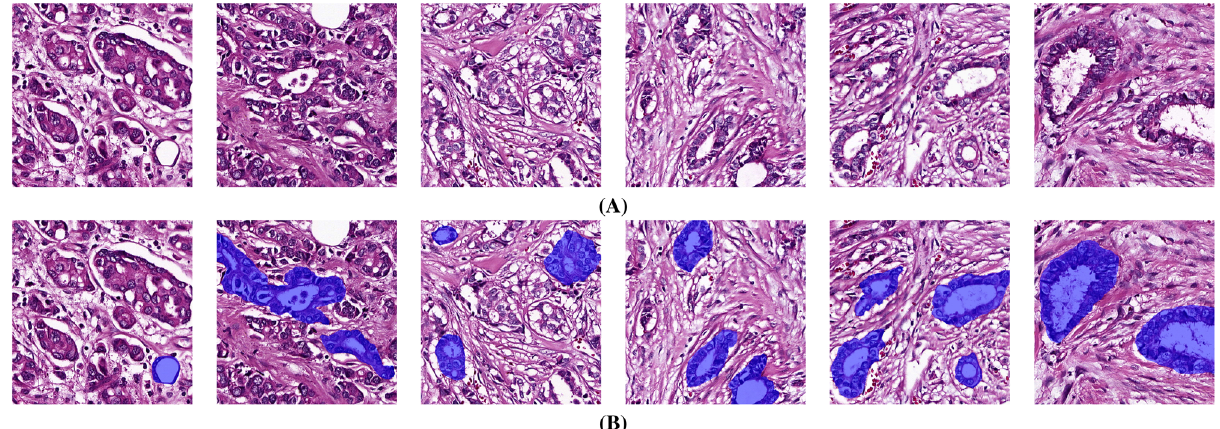
Figure 1. Several example patches with tubule structures which are manually segmented by an expert pathologist. ( A ) Original patches, ( B ) manually segmented tubules shown in blue color.